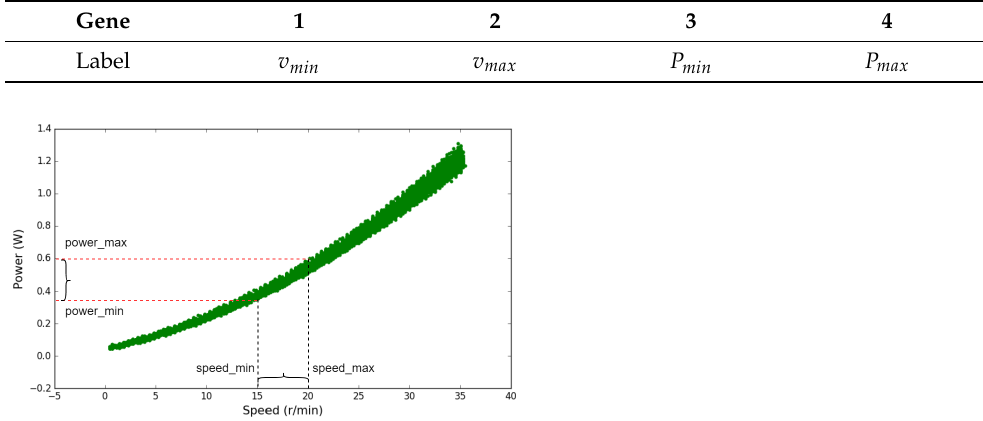
Figure 6. The upper and lower bound of power given a speed interval define a